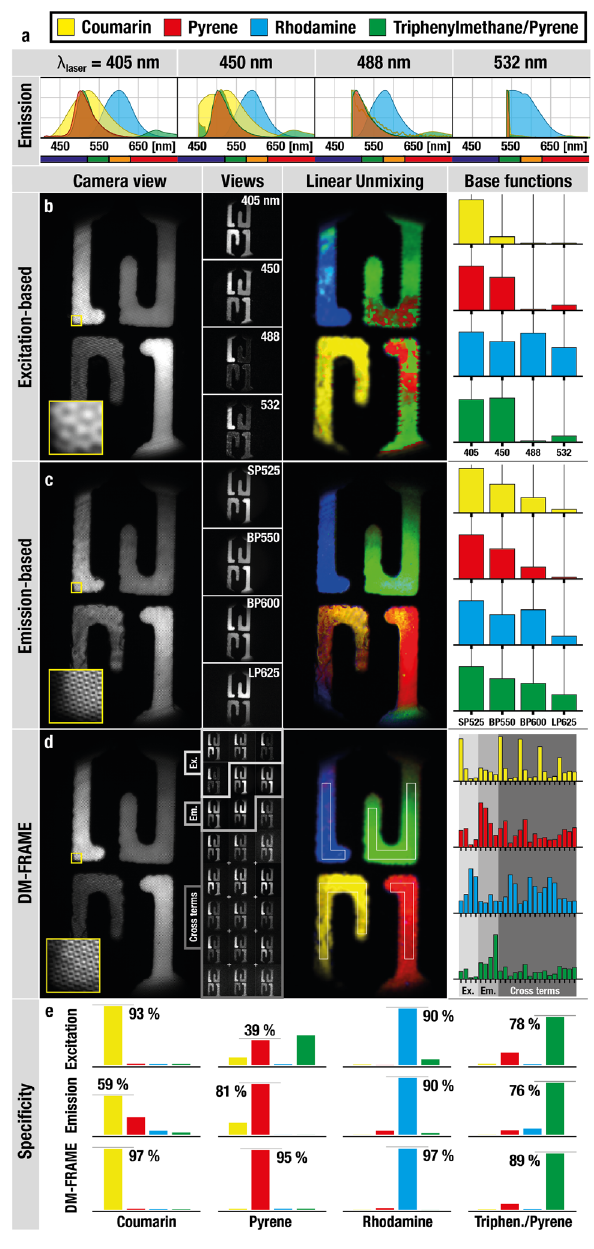
Figure 2. Improved spectral sensitivity gained by DM-FRAME. Measurements of four different dyes with very similar excitation and/or emission characteristics, analyzed using linear unmixing. ( a ) Spectral responses for each fluorophore at each excitation wavelength, together with an indication of the spectral bandwidths of the emission filters. ( b ) Excitation-based multiplexed imaging, ( c ) emission-based multiplexed imaging and ( d ) DM-FRAME. Each measurement contains sufficient information to theoretically identify the dyes but due to the strong spectral overlap, both the emission-based and excitation-based methods are prone to misidentification, see ( e ). However, when combining the methods using DM-FRAME, the faint differences between the dyes’ spectral characteristics can be detected, yielding highly accurate identification (measured for the signal in the areas marked in d